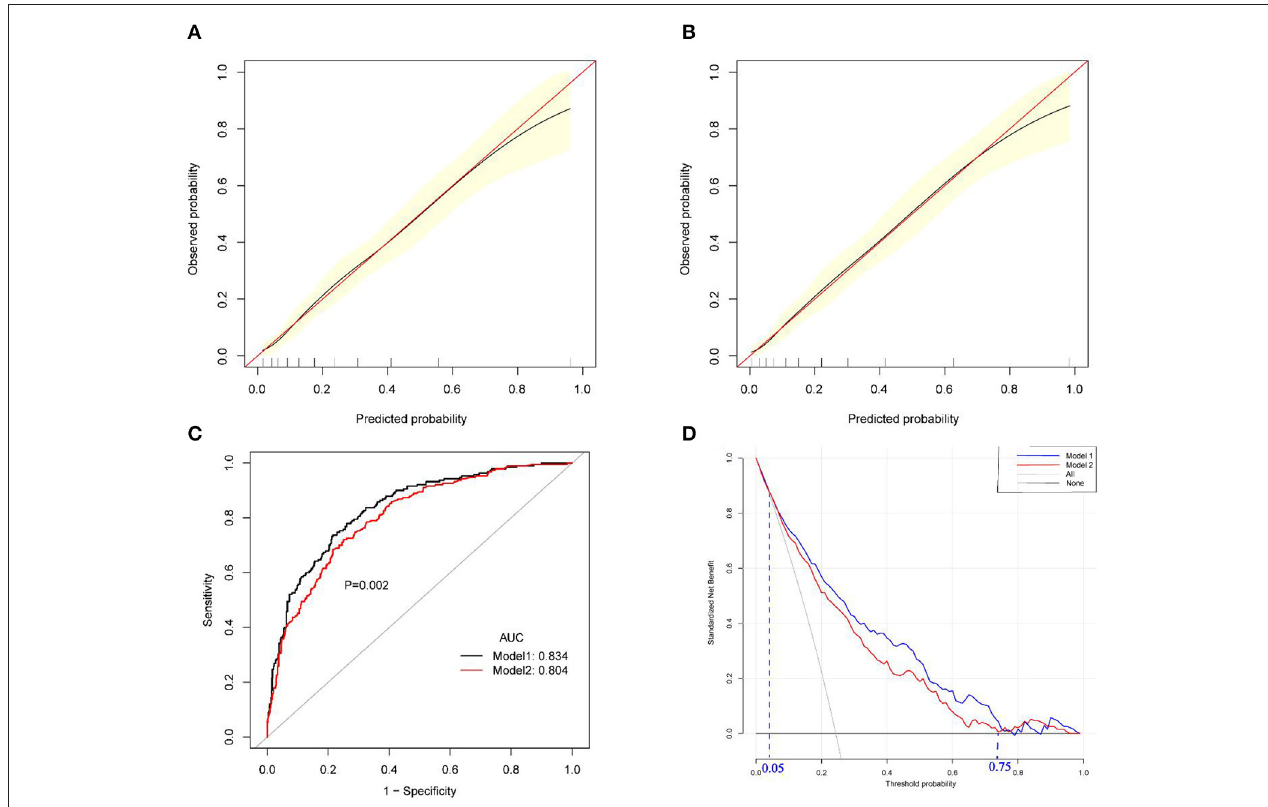
FIGURE 4 | Validation and decision curve analysis of Model 1 and Model 2. (A) Calibration curve of Model 1; (B) calibration curve of Model 2; (C) Receiver operating characteristics curves of Model 1 and Model 2; (D) Decision curve analysis of Model 1 and Model 2. AUC: area under the